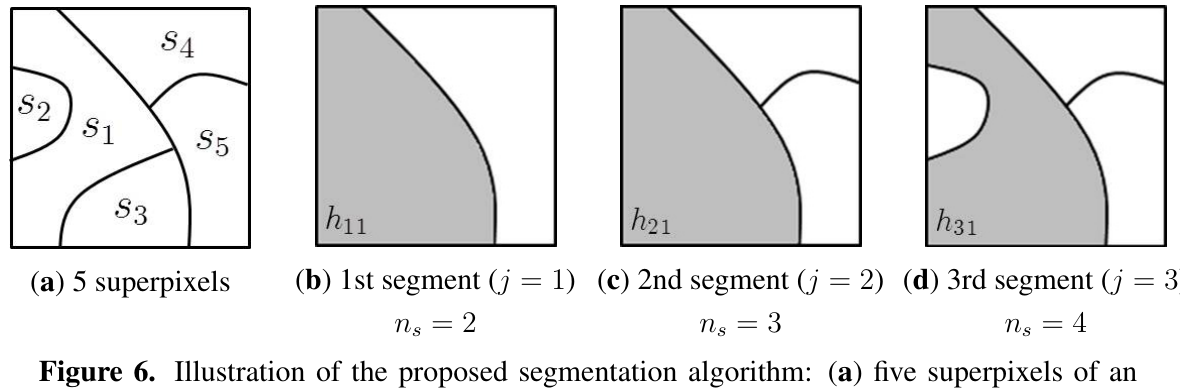
for three hypotheses, such as h 1